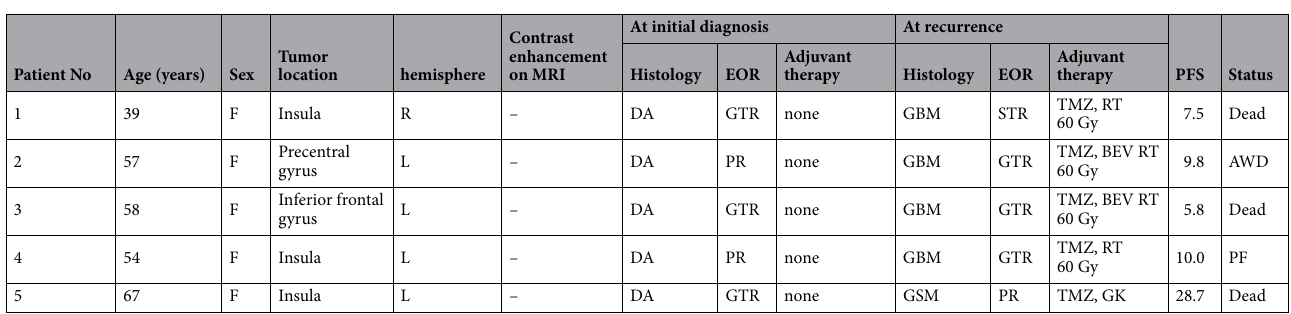
Table 1. Clinical characteristics of five patients with localized IDH wild-type histologically diffuse astrocytomas. MRI magnetic resonance imaging, EOR extent of resection, DA diffuse astrocytoma, GTR